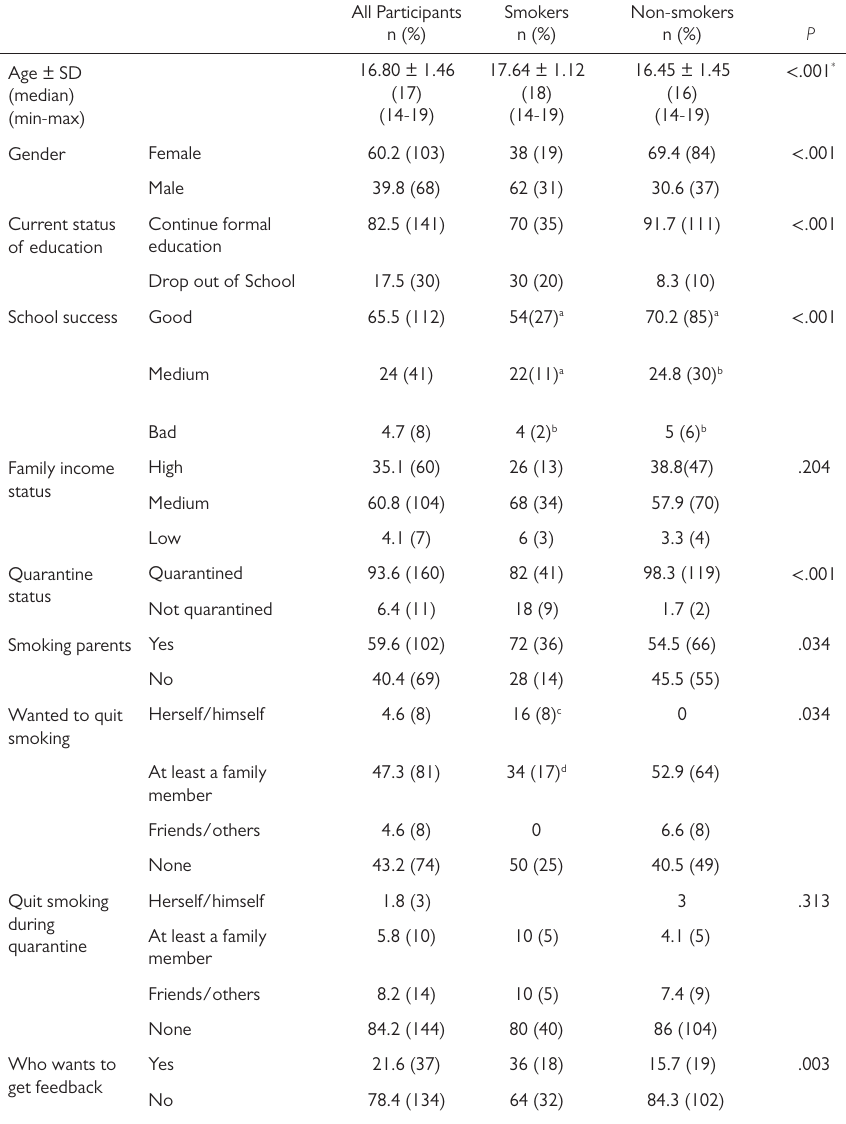
Table 1. Demographic Characteristics of the Participants